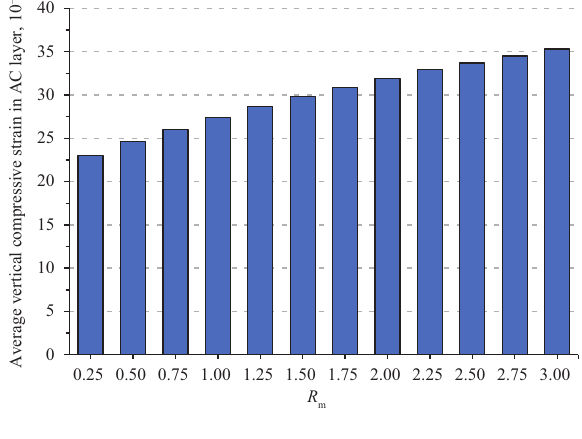
Figure 10. The average vertical compressive strain in the AC